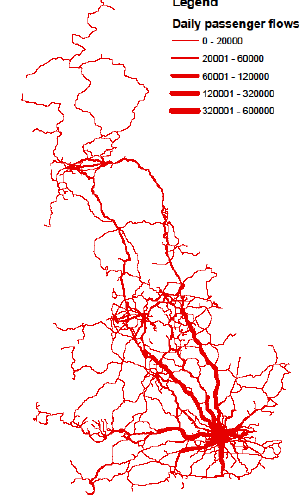
Figure 3. Results of the railway trip assignment analysis showing estimates of daily number of passenger trips across individual railway network edges (track